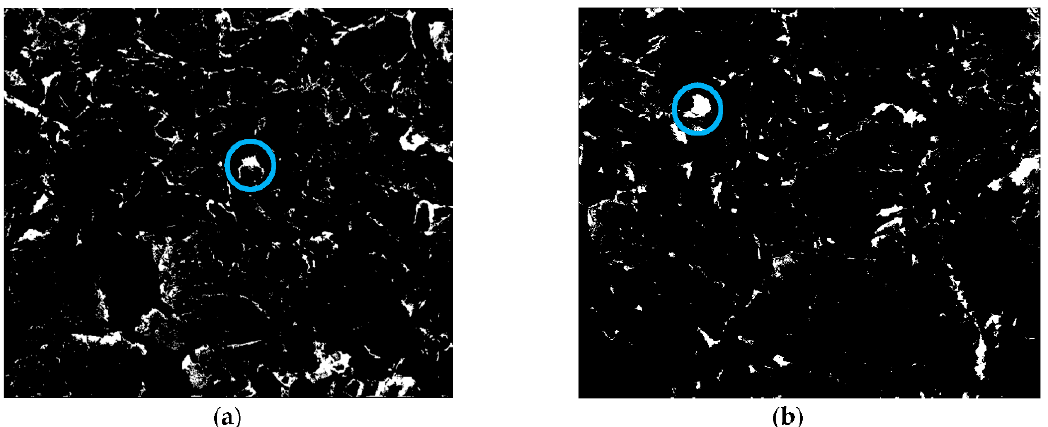
Figure 11. Binarized scanning pictures: ( a ) unfrozen soil before cyclic loading; ( b ) unfrozen soil after cyclic loading.